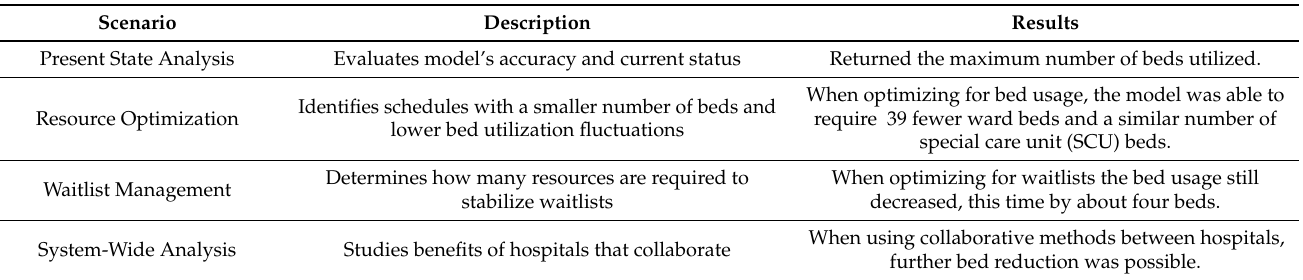
Table 5. Outpatient Scheduling